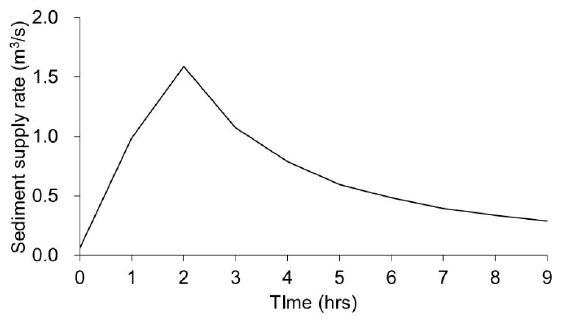
Figure 4. Sediment supply rate in Run 1. Table 1. Calculation conditions.